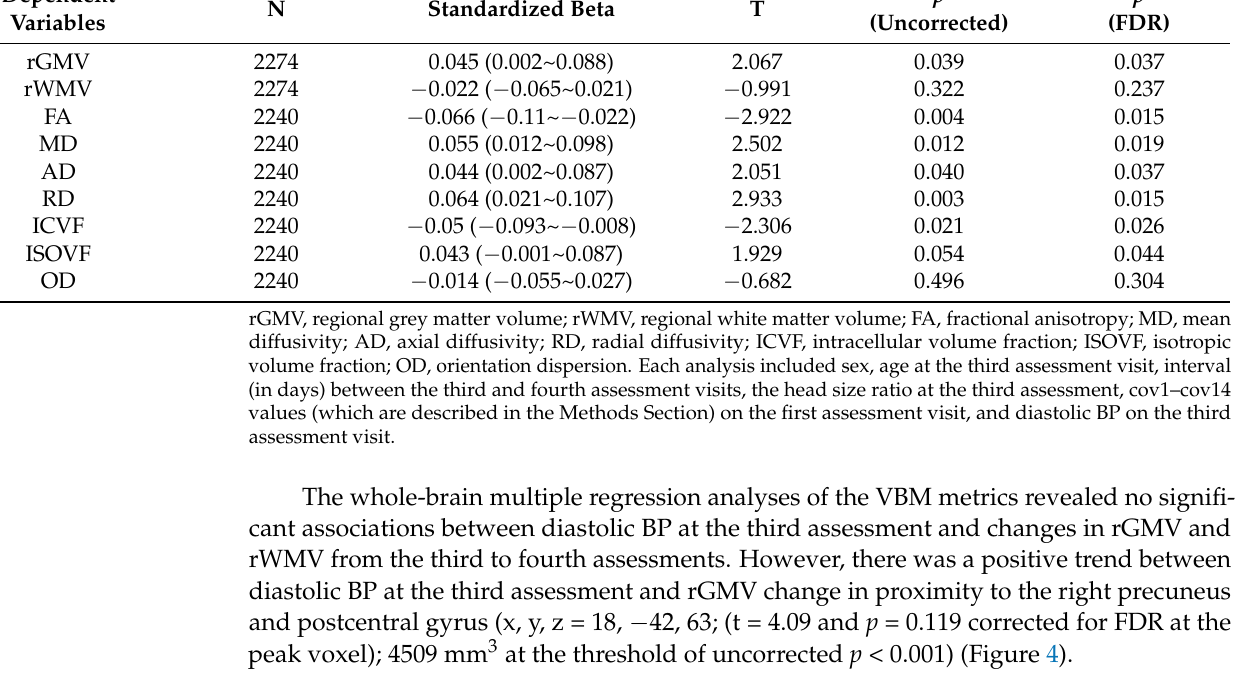
Figure 3. Associations of diastolic BP with subsequent changes in total, mean, or regional imaging measures. Error bars represent the standard error of the mean. ( a ) Total grey matter volume (GMV). ( b – g ) Mean white matter metrics: ( b ) functional anisotropy (FA), ( c ) mean diffusivity (MD), ( d ) axial diffusivity (AD), ( e ) radial diffusivity (RD), ( f ) intracellular volume fraction (ICVF), and ( g ) isotropic volume fraction (ISOVF). Multiple regression analyses adjusting for confounding variables revealed that a greater diastolic BP was associated with a subsequent relative increase in rGMV, greater decline in FA, greater increases in MD, AD, and RD, greater decline in ICVF, and greater increase in ISOVF ( p < 0.05, corrected for FDR). Table 2. Associations between baseline diastolic BP (third assessment) and longitudinal changes in morphometric or diffusivity parameters revealed by multiple regression analyses.